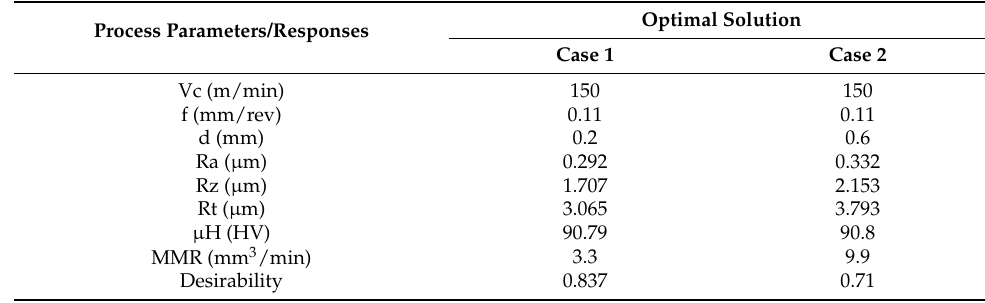
Table 10. Optimal combination of process parameters with their respective